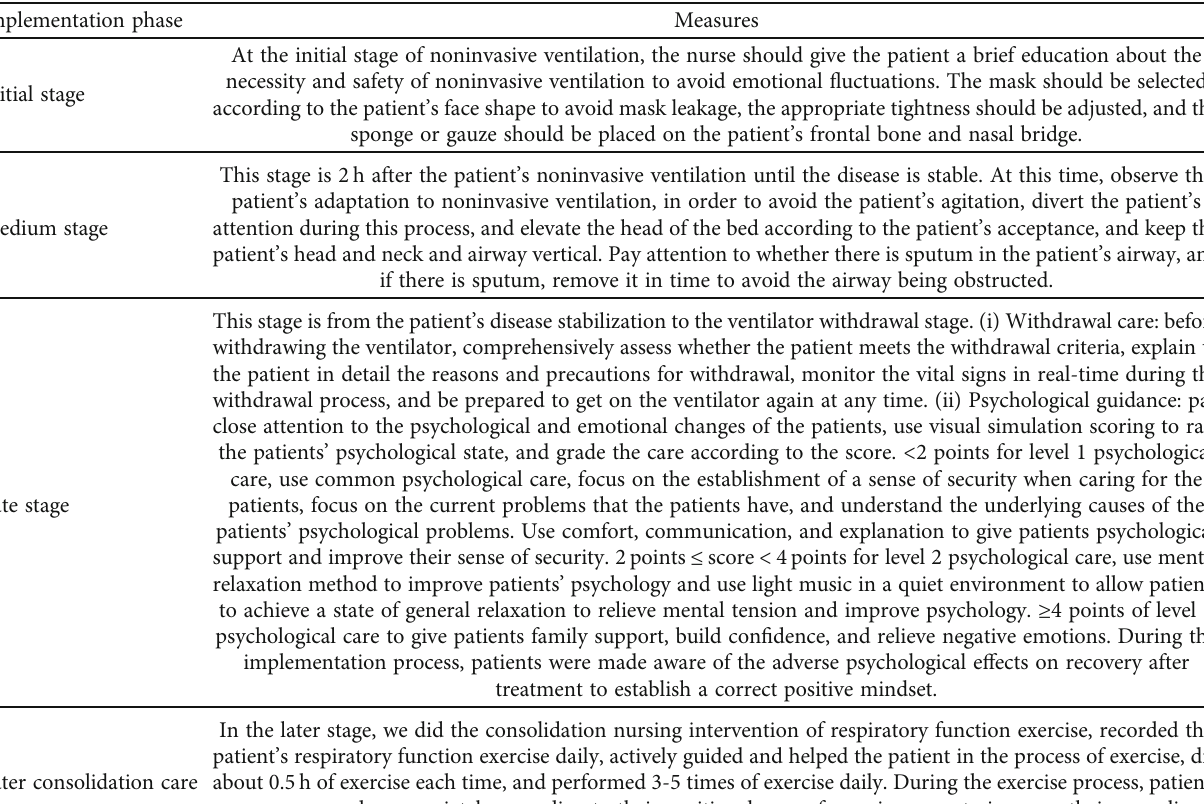
Table 2: Speci fi c care